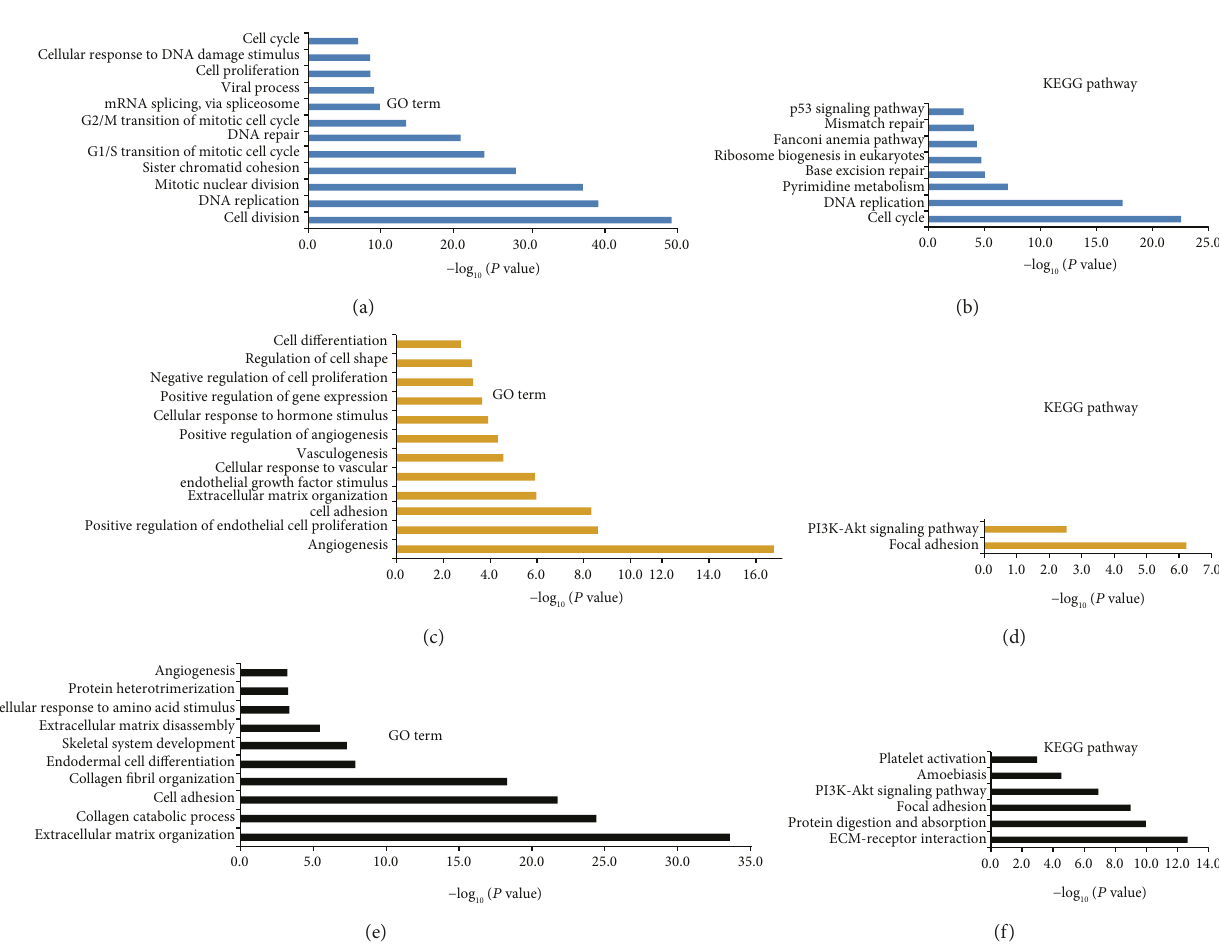
Figure 3: Biological function of DEGs in each module. (a) Gene Ontology and (b) KEGG pathway enrichment analysis for the blue module. (c) Gene Ontology and (d) KEGG pathway enrichment analysis for the yellow module. (e) Gene Ontology and (f) KEGG pathway enrichment analysis for the black